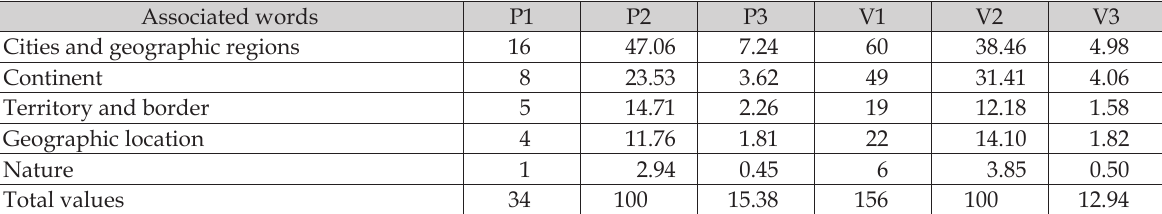
Table 2. Categories shaping the semantic field on geographic concepts and places after an associated word test on students in training to be teachers in secondary